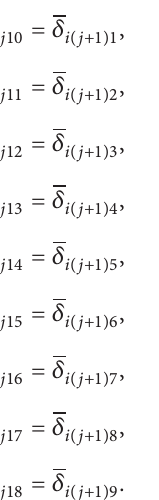
Considering the constraints of moving platform on the right end point of the 𝑚 unit, the curvatures of end points on different telescopic rod of driving limb 𝑖 are not